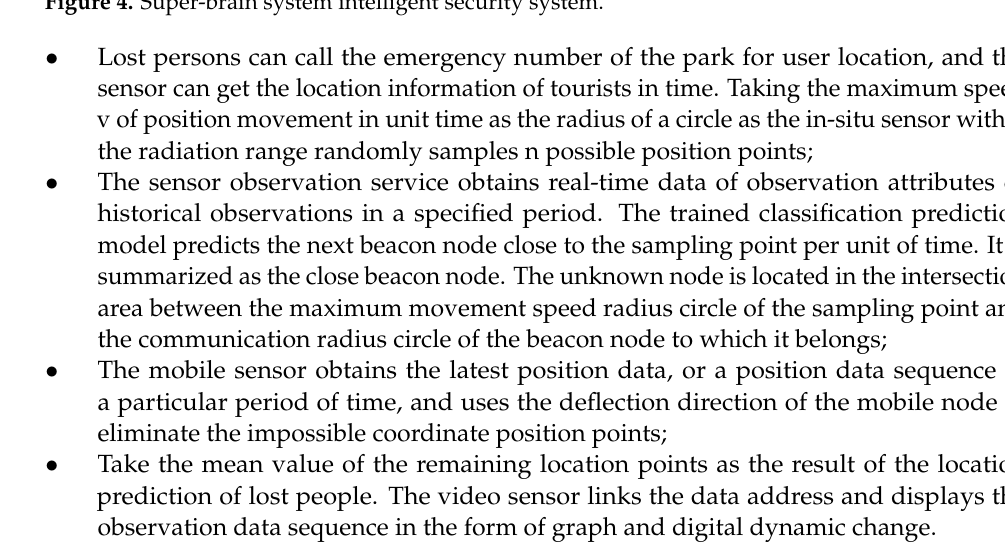
Figure 4. Super-brain system intelligent security system.